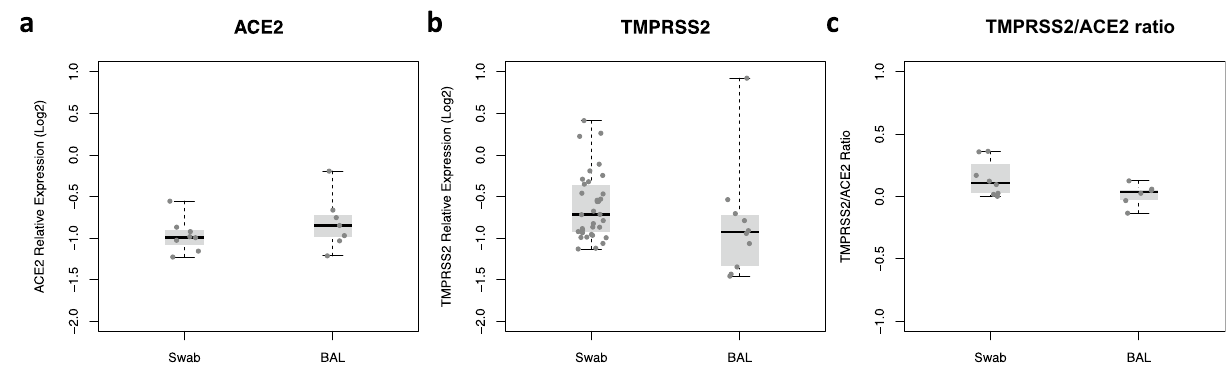
Figure 3. ACE2 and TMPRSS2 expression levels on upper and lower respiratory tract of severe COVID-19 patients with respiratory failure. Relative expression levels of ACE2 ( a ) and TMPRSS2 ( b ) were determined by RT-qPCR on samples from nasopharyngeal swabs and bronchoalveolar lavages (BAL). TMPRSS2/ACE2 ratio were calculated for each individual and compared between swabs and BAL samples ( c ). Results are represented in log-scale (base 2) relative to B2M expression. Boxes represent mean and interquartile range, and whiskers represent upper and lower limit. Linear regression models were applied for comparisons between